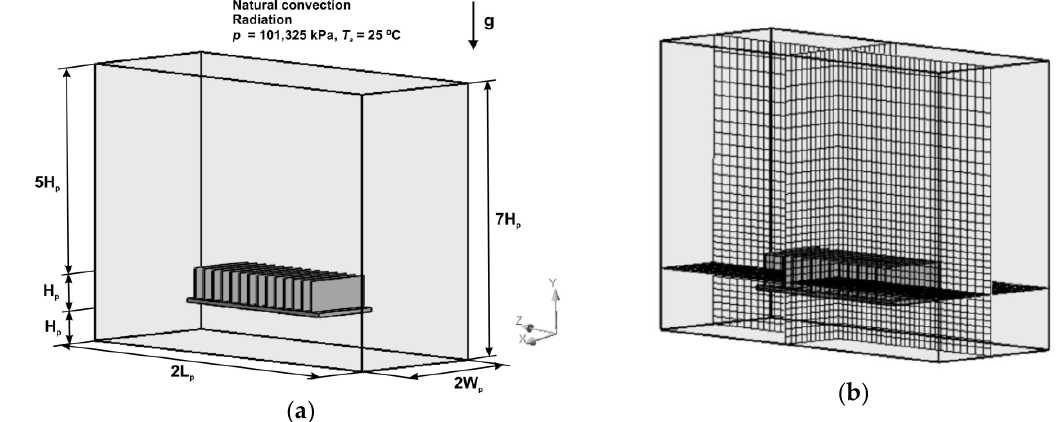
Figure 9. Simulation model of the LED panel with a radiator with fourteen fins: ( a ) computation domain with the assumed boundary conditions and ( b ) cross-section of the computation grid along the XYZ axis.